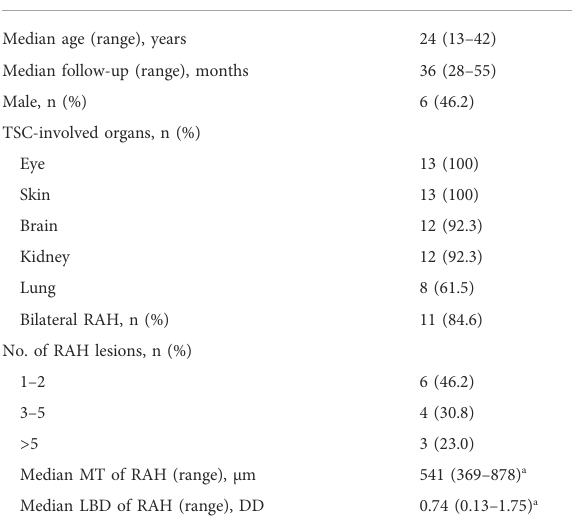
TABLE 1 Patient baseline